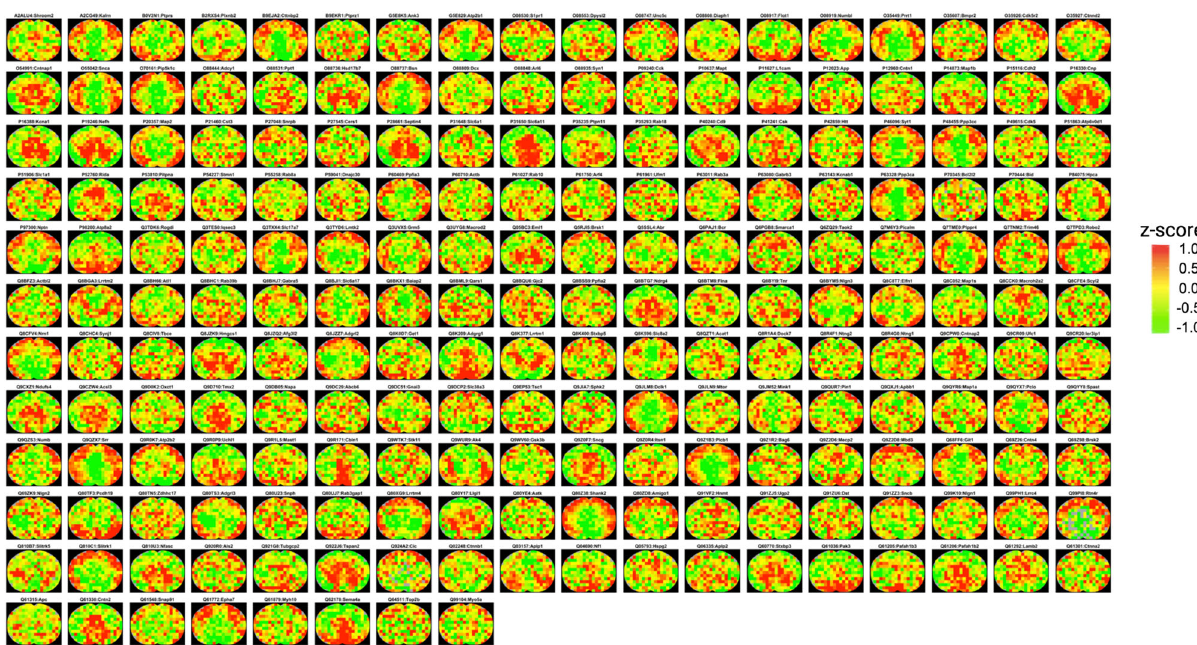
Fig. 4 | Representative examples showing MASP ’ s potential in providing insights into spatially-organized biological processes. The spatial distribution maps of the proteins involved in developmental processes in the brain,